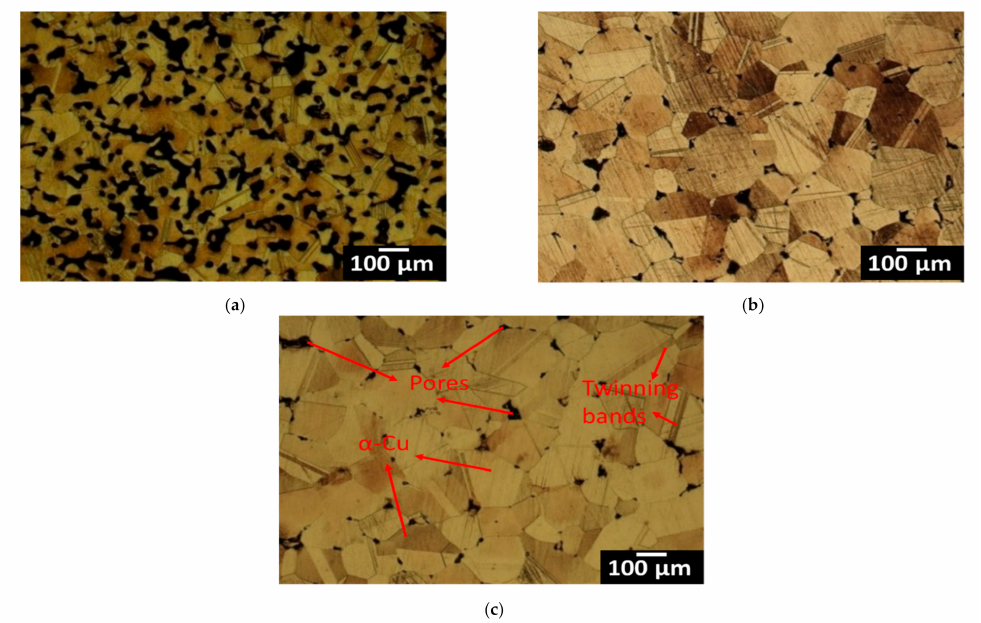
Figure 7. Microstructural images of sintered samples at ( a ) 850 °C, ( b ) 875 °C and ( c ) 900 °C.